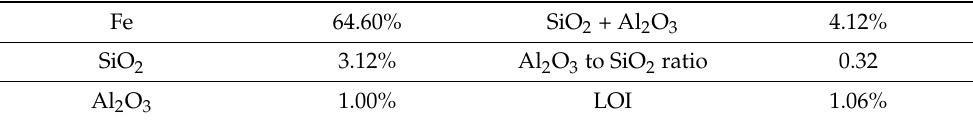
Table 6. Specification of final